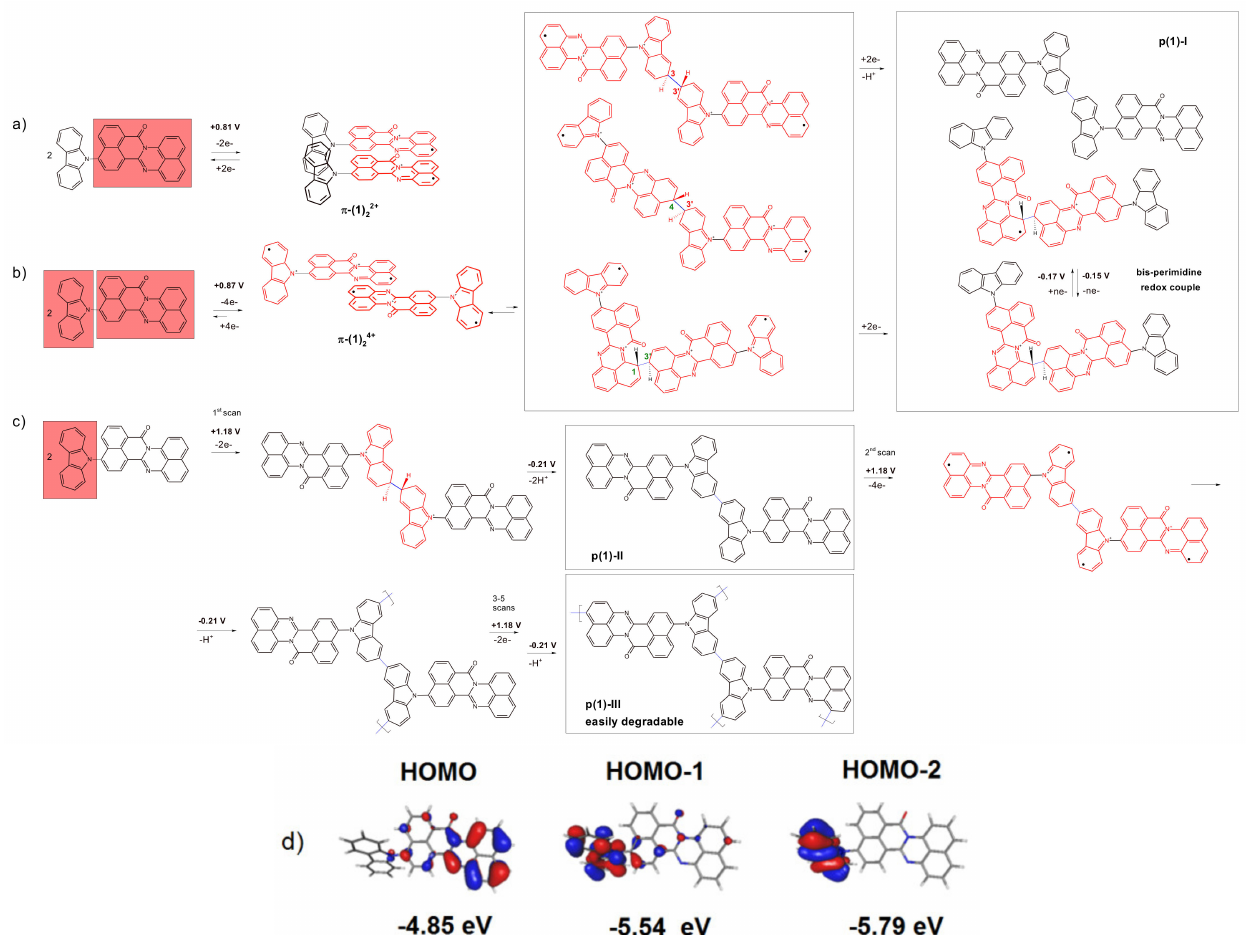
Scheme 2. Proposed mechanism of 1 electrooxidation limited by the first ( a ), second ( b ) and third oxidation peak ( b ); with the production of π -[1] 22+ , π -[1] 24+ dimers ( a,b ) and solid product p(1)-I ( b ); p(1)-II and p(1)-III ( c ); polarized segment of 1 on a red background , new bonds in blue ; shape of frontier orbitals of 1 ( d